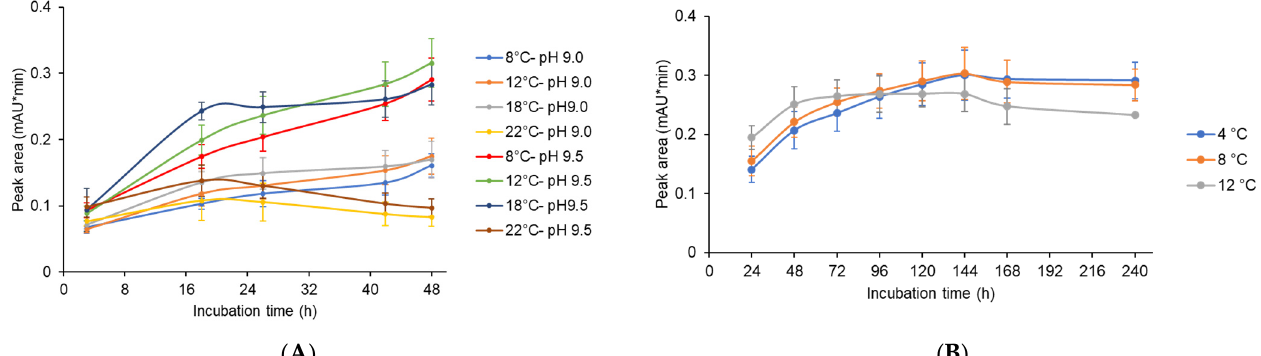
Figure 8. Post-fermentation approaches to obtain significant productivity of CCAA (XUL-4.6). ( A ) Optimization of temperature and pH conditions for the deacylation reaction of CCA. The supernatants of 72 h of culture were modified to pH 9.0 and pH 9.5, which are close to the preferred environment for the deacylation, and incubated at different temperatures from 8 °C to 22 °C for up to 48 h. Samples were taken at different time points and HPLC analysis was followed, and the peak areas of CCAA deacylation product 7-ACA were plotted. For every condition, at least three independent experiments were conducted. ( B ) The maximal production of 7-ACA was observed for the extended incubations at low temperatures. The supernatants were adjusted to pH 9.5 and incubated at 4 °C to 12 °C for up to 240 h.